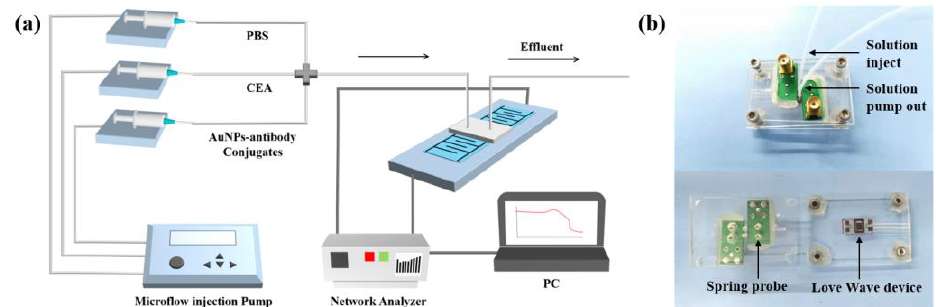
Figure 1. ( a ) Schematic illustration of the CEA measurement system; ( b ) photos of the detection platform based on the SAWs and the PDMS microchannel.